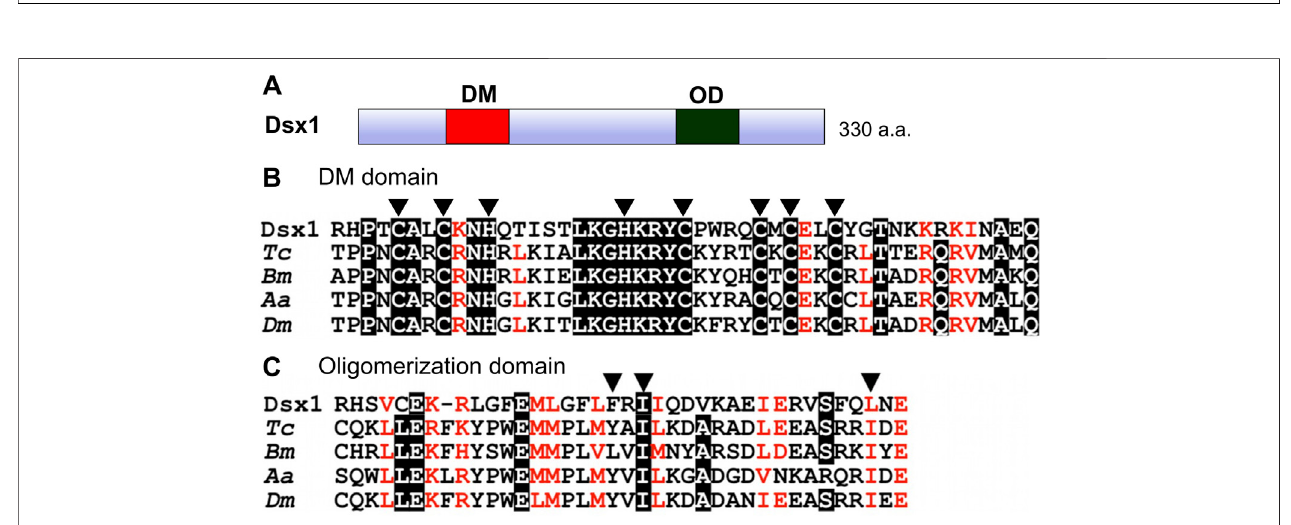
FIGURE 2 | Domain organization of Dsx1 . (A) Schematic representation of Dsx1 . DM: DM domain, OD: Oligomerization domain. (B) Amino acid sequence alignment of DM domains from arthropod Dsx orthologs. Arrowheads indicate zinc-chelating amino acids. (C) Amino acid sequence alignment of oligomerization domains of arthropod Dsx orthologs. Arrowheads indicate three non-polar amino acids involved in the formation of the interface. Dsx1 , D. magna Dsx1 ; Tc, Tribolium castaneum ; Bm, Bombyx mori ; Aa, Aedes aegypti ; Dm, Drosophila melanogaster . Adapted and modi fi ed from Kato et al. (2011).